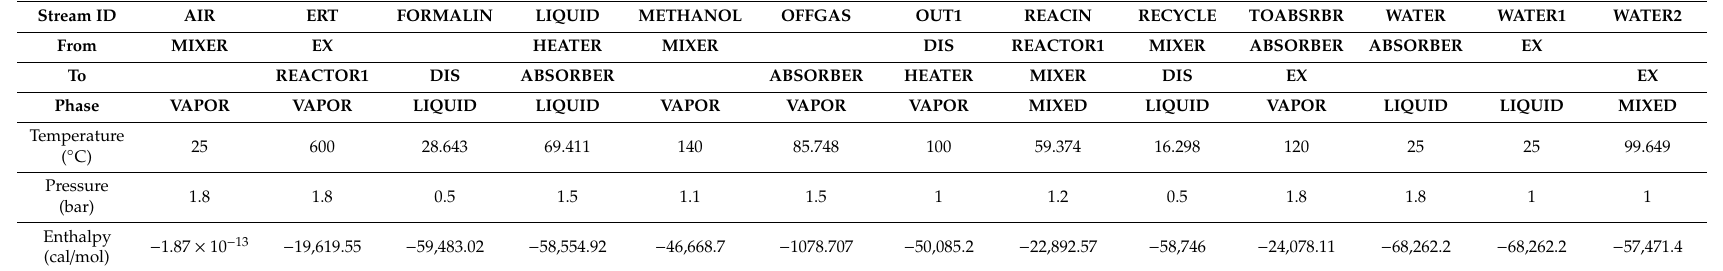
Table 5. Energy balance of silver-based